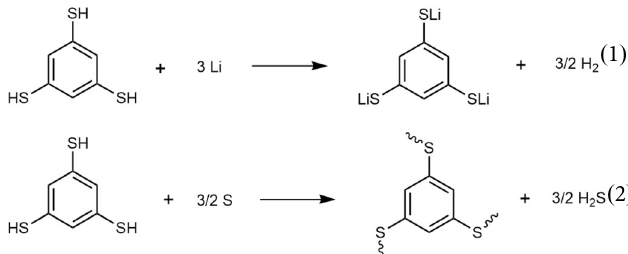
to solve the both electrodes